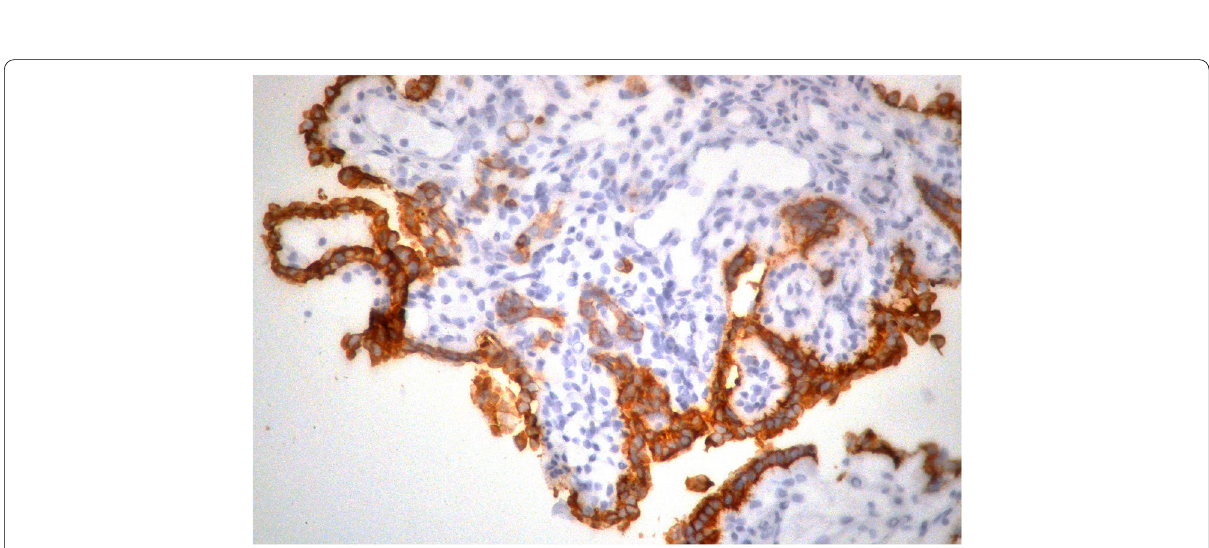
Fig. 4 Bladder nephrogenic adenoma. All epithelial cells are positively stained (immunohistochemical reaction with antibodies to cytokeratin 7, ×